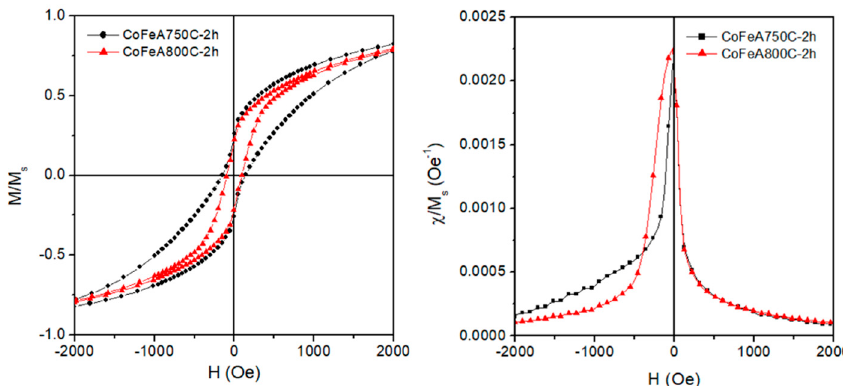
Figure 7. ( Left panel ) magnetic hysteresis loops measured at room temperature on two CoFe ceramic NCs obtained starting from A zeolite; ( right panel ) normalized magnetic susceptibility of the same samples.